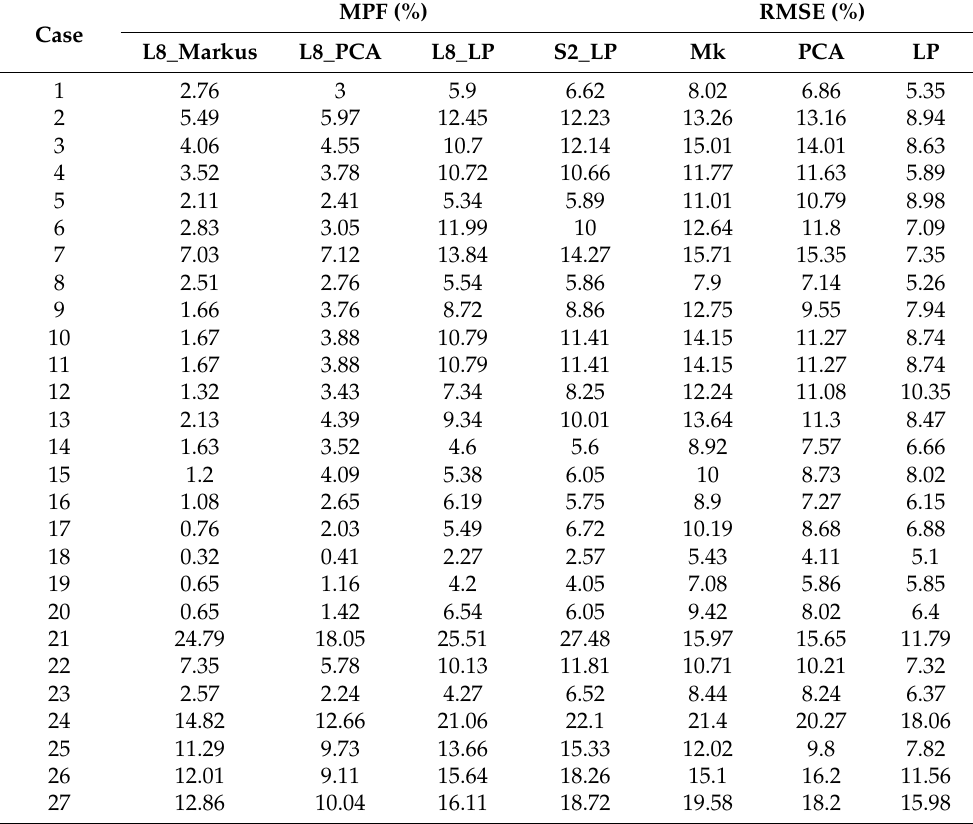
Table A1. The average MPF and RMSE for the 80 cases between the 3 algorithms on L8 and LinearPolar algorithm on